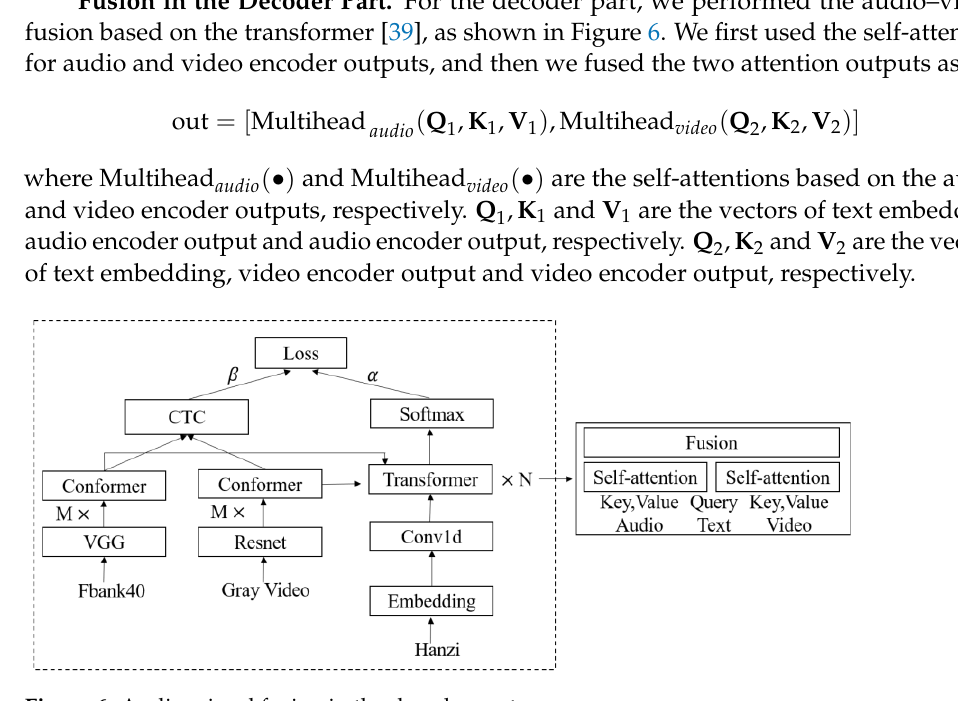
Figure 6. Audio – visual fusion in the decoder part. Figure 6. Audio–visual fusion in the decoder